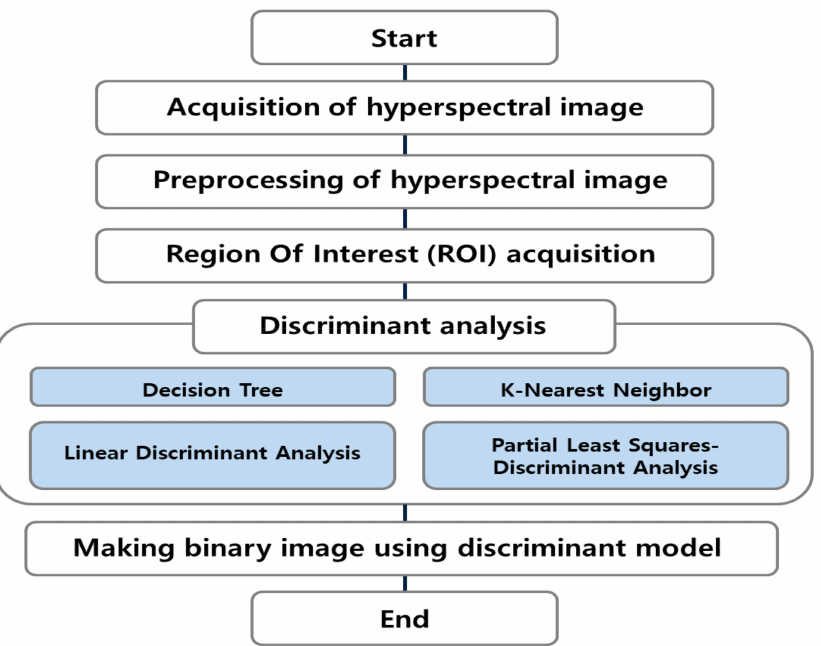
Figure 3. Flowchart of detecting bacterial biofilms using discriminant